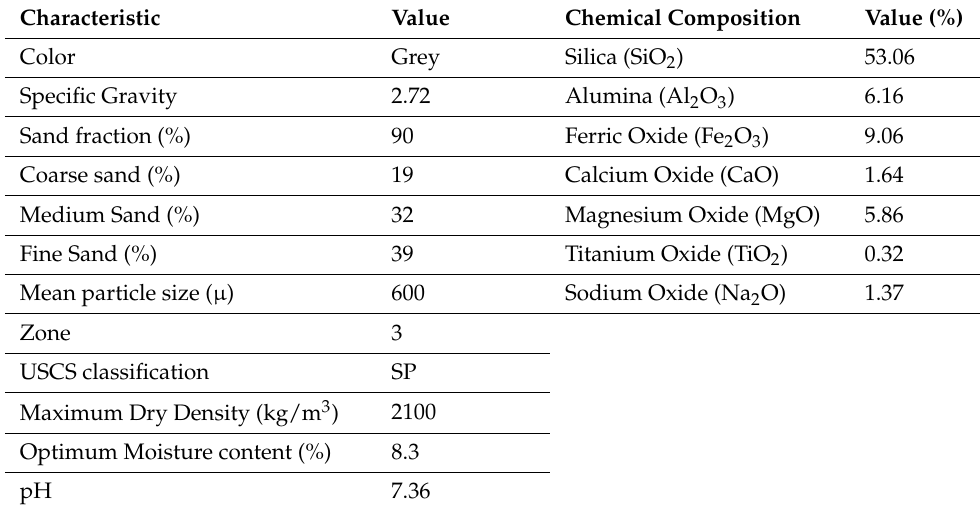
Table 2. Basic Characteristics and Chemical Composition of GS.